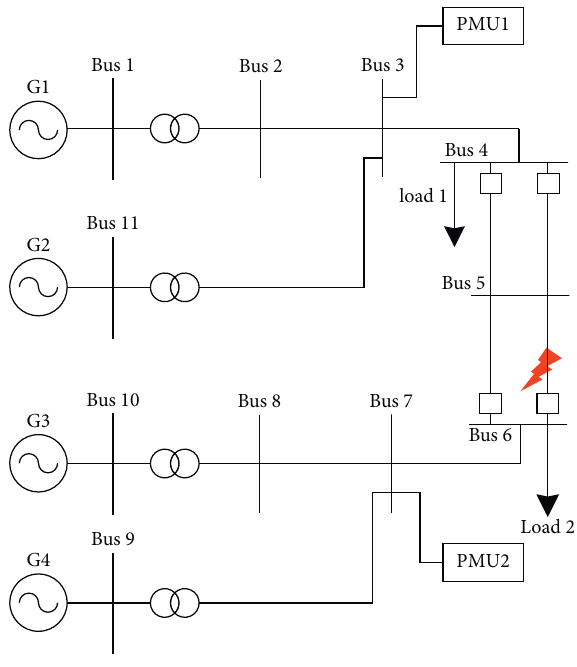
Figure 12: Kundur two area